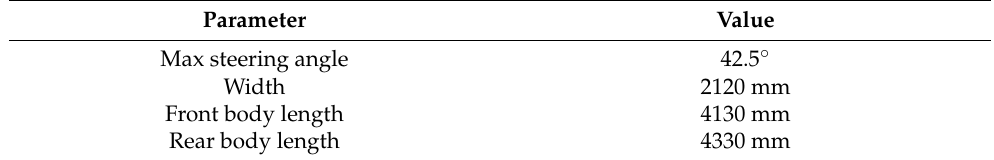
Table 2. Parameters of the Scooptram ST3.5 diesel LHD. Figure 12. Scooptram ST3.5 diesel LHD.